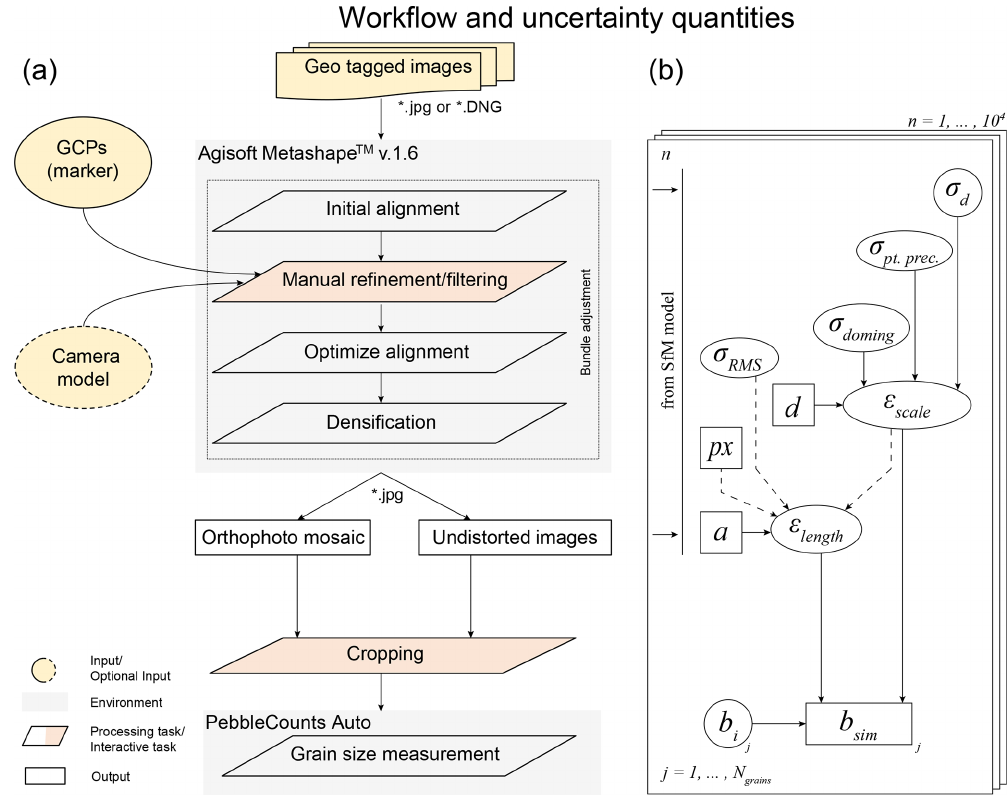
Figure 3. Workflow for grain size estimations from UAV-derived images. (a) Structure from motion workflow with PebbleCountsAuto (Purinton and Bookhagen, 2019) for grain size estimation. (b) Quantities used for estimating the uncertainty in the grain sizes. Quantities in squares denote image- and/or survey-specific values, while variables in ellipses are represented by a probability density function (pdf). Dashed arrows indicate quantities only used for uncertainty estimation in orthomosaics. For variable explanation, see Sect. 2.4 in the main